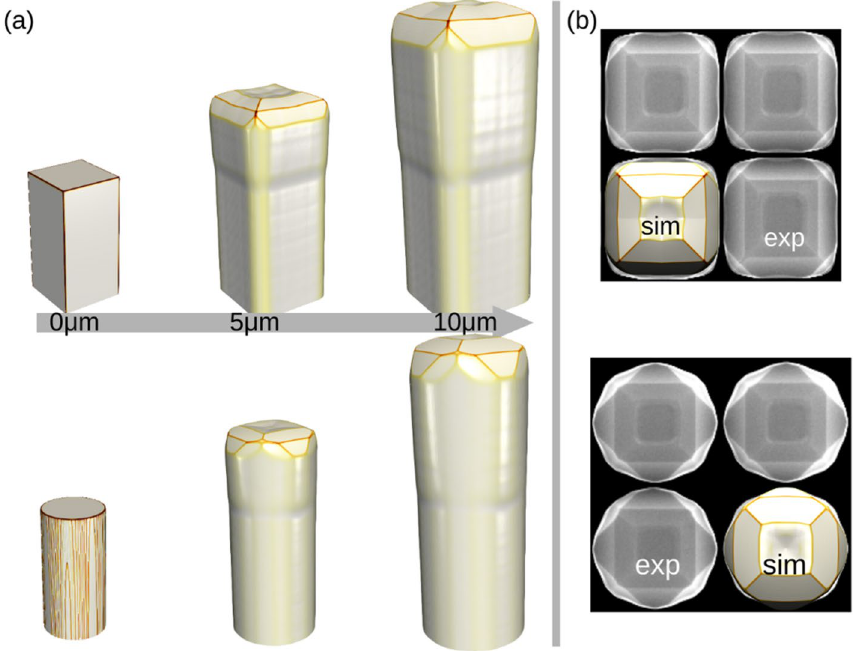
Figure 6. Pillar template effect. ( a ) The evolution of the microcrystals at different deposition stages on Si pillars with different shapes as predicted by the simulations (top: parallelepiped shape; bottom: cylindrical shape) and ( b ) experimentally observed. Top views of the simulated profiles are superposed to the SEM images for comparison. The initial Si pillar is 4 μm wide, and 10 μm of Si is deposited.